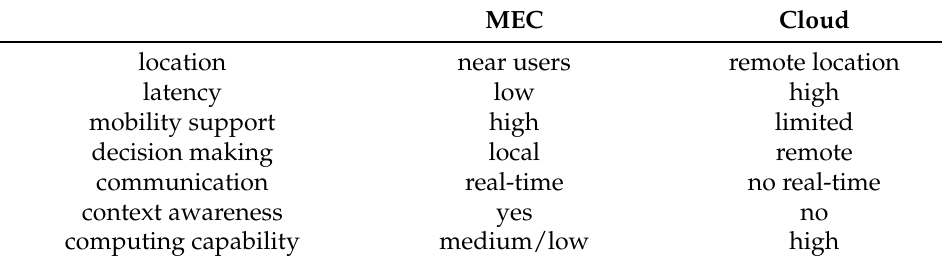
Figure 1. Reference Scenario. Table 1. Comparison between MEC and Cloud computing in